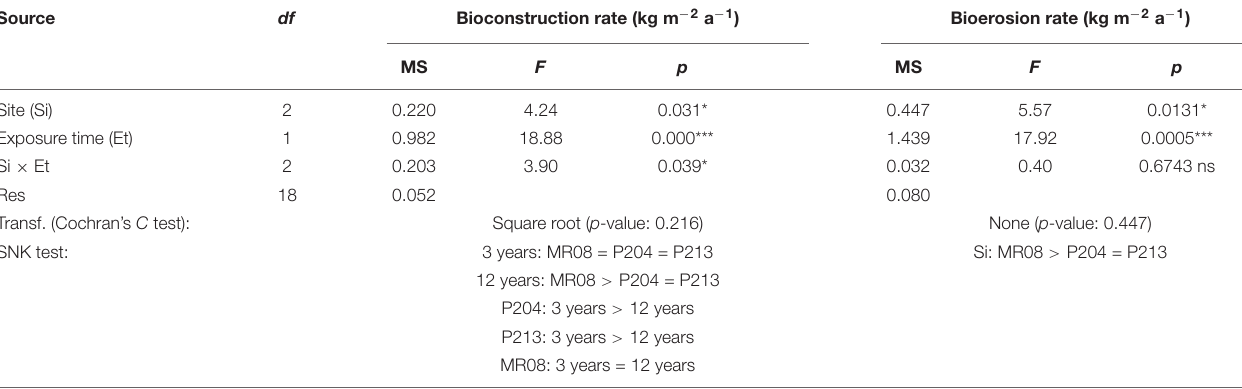
TABLE 3 | Results from ANOVA on bioconstruction and bioerosion rate.